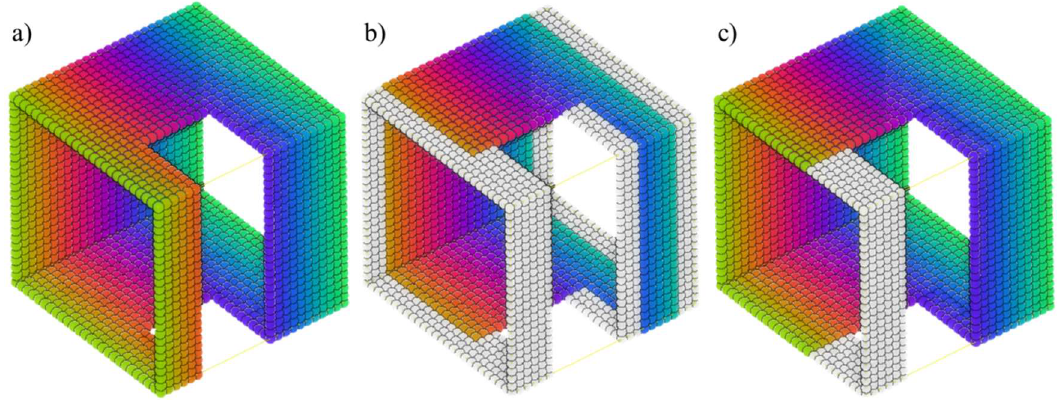
Figure 5 . Morphological opening for removing small areas: a) Input point cloud, b) eroded point cloud) and c) dilated point cloud. Note: Input data is preserved in grey colour for improving visualisation.